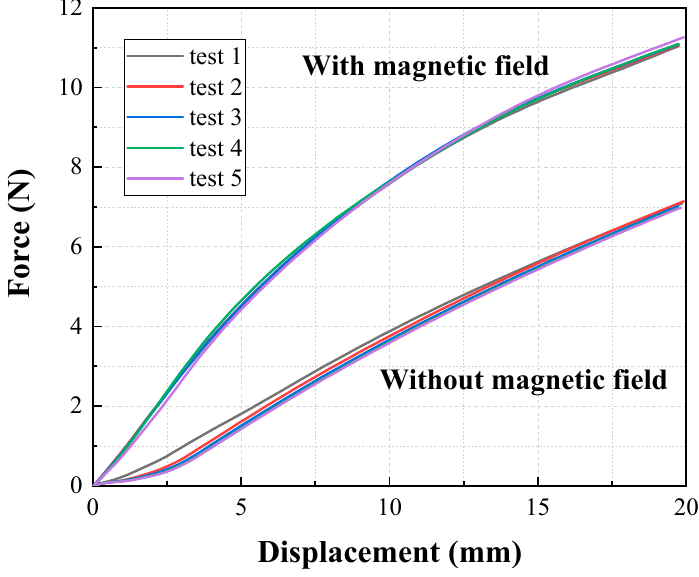
Figure 8. Intra-specimen repeatability test results of five samples (rectangular) under the same conditions.